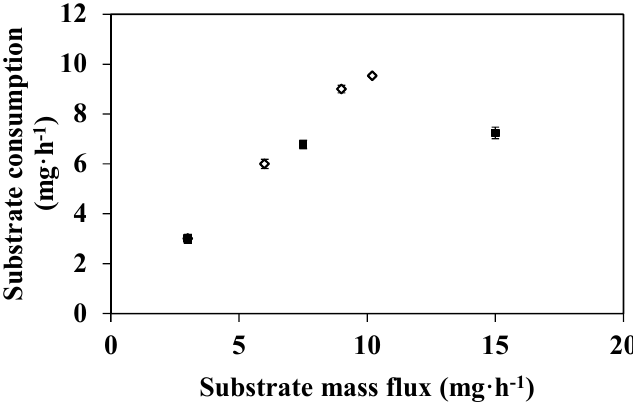
Figure 5. Substrate mass flux effect on DMP degradation in an EMR used in a continuous dead-end filtration configuration (DMP in 50 mM citrate-phosphate buffer pH 4 with 0.1 mM CuSO 4 , T = 40 °C, membrane pore diameter: 0.2 μ m) (reactor fed with 100 mg·L − 1 DMP at flow rate increased ( ◊ ); reactor fed at flow rate constant 11 L·h − 1 ·m − 2 with 100, 250 and 500 mg·L − 1 DMP ( ■